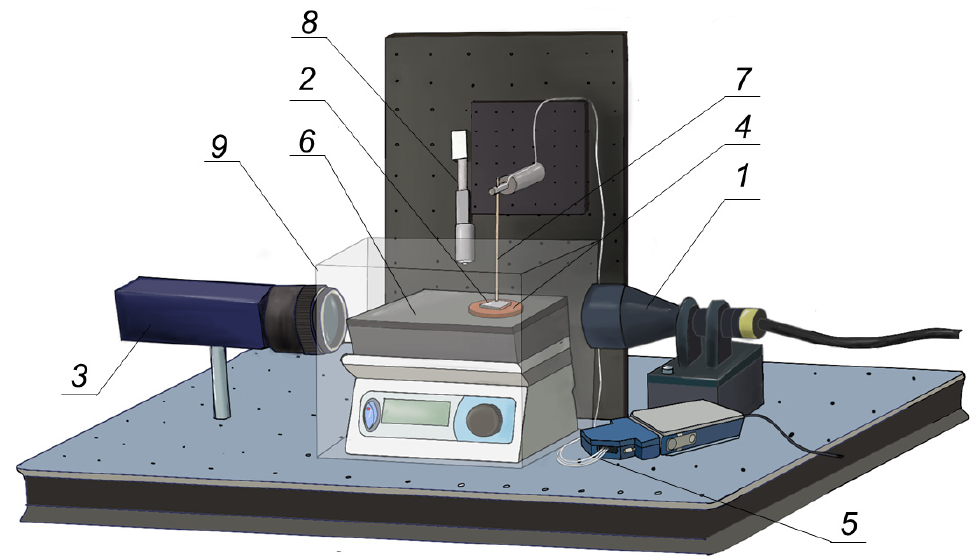
Figure 1. Experimental setup: 1 —plane-parallel light source; 2 —metal sample; 3 —high-speed video camera; 4 —copper disk; 5 —thermocouples recording the temperature on and under the metal sample; 6 —temperature input module; 7 —glass–ceramic heater; 8 —precise positioning system; 9 —polymer glass box.